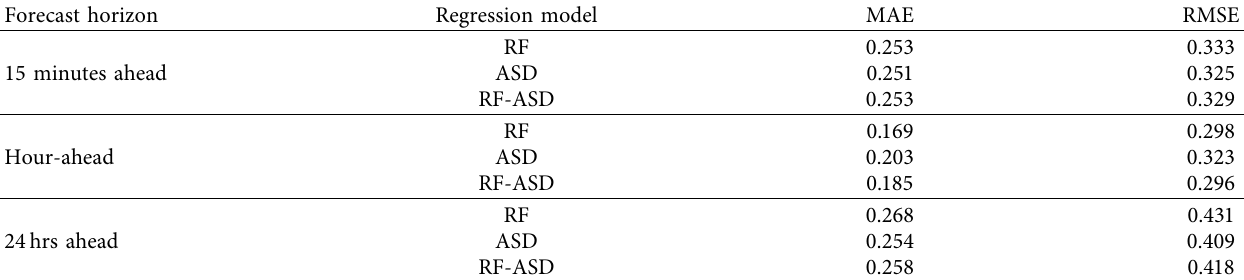
Table 3: Overall performance for blackout forecast regression models.